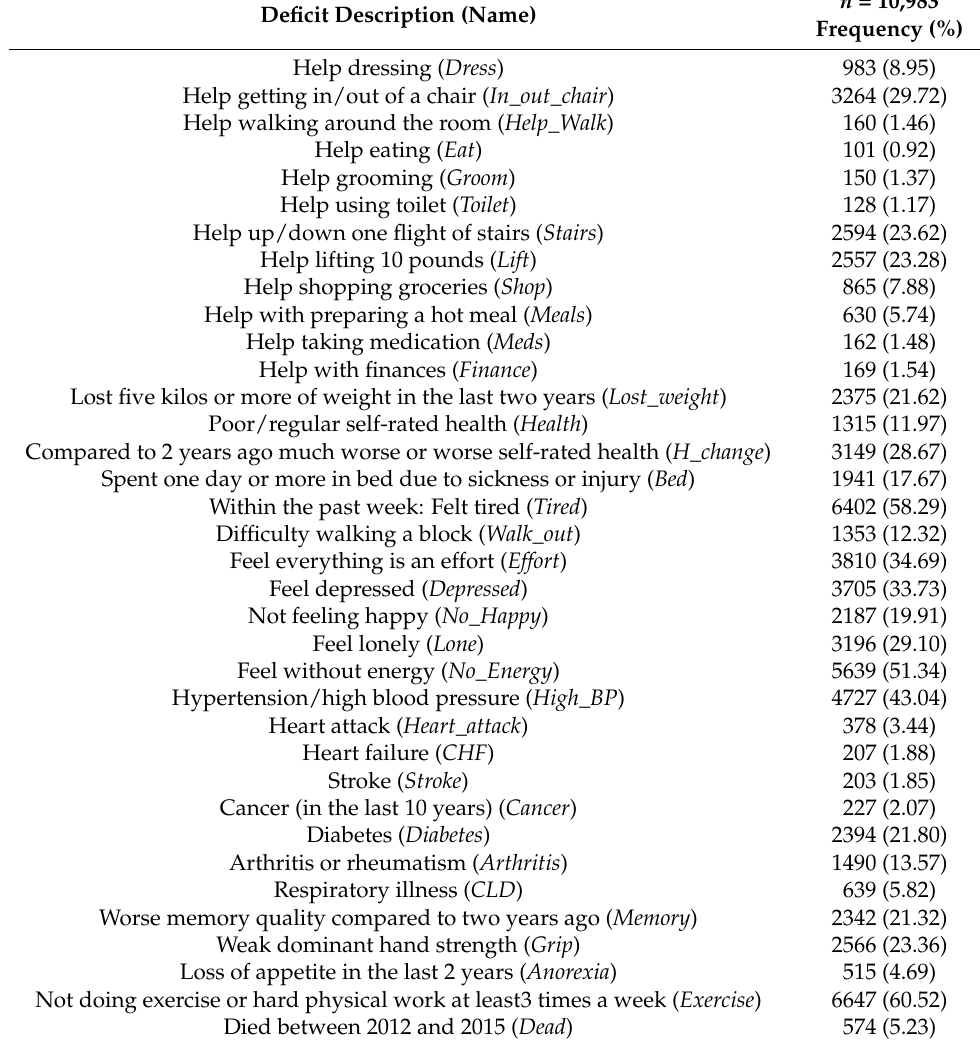
Table 1. Prevalence of the 35 deficits included in the Frailty Index and death in the total